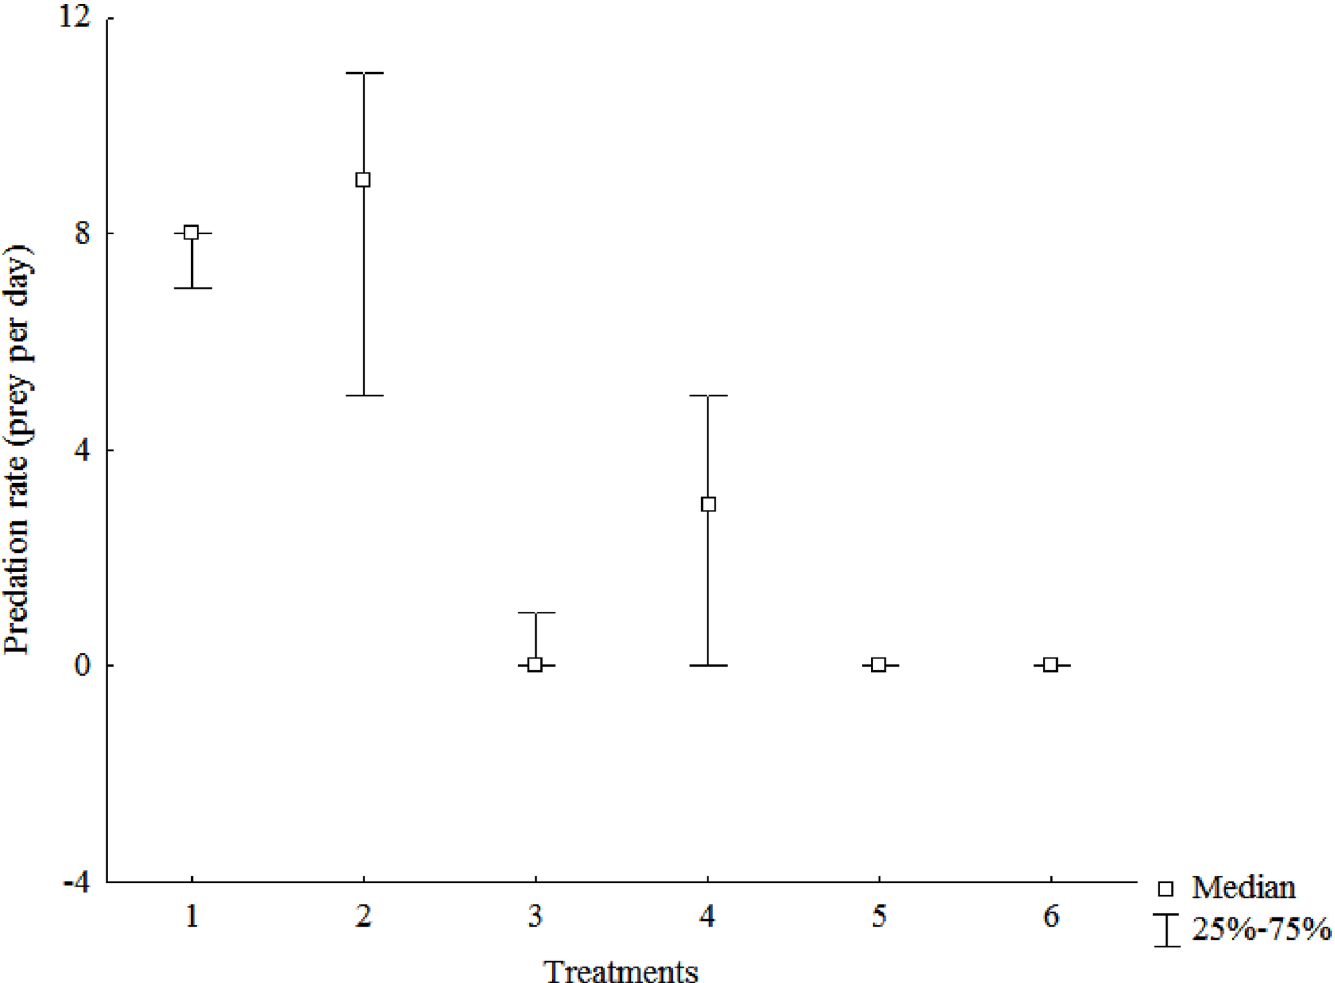
Fig 4. Predation rates of Mesostoma ehrenbergii on Mesostoma craci . The box represents the 25 and 75% quartiles and the band in the box is the median